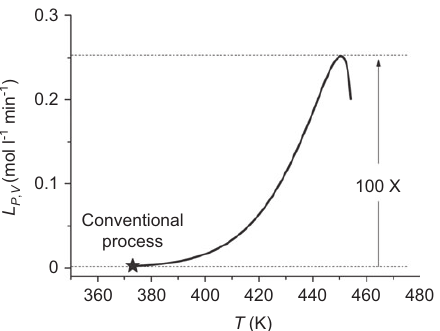
Figure 6 Specific performance L as a function of the temperature p,v as a function of the tempera- representative for the determination of the optimal novel process p,v window for different equilibrium conversions at P = 10 bar, for con- = 0.4 m , C = 1.2 m and X = 30%. = 1 m and C = 5 m . The conventional batch centrated solutions C 1,0 KHCO 3 ,0 1,0 KHCO 3 ,0 process is represented by the